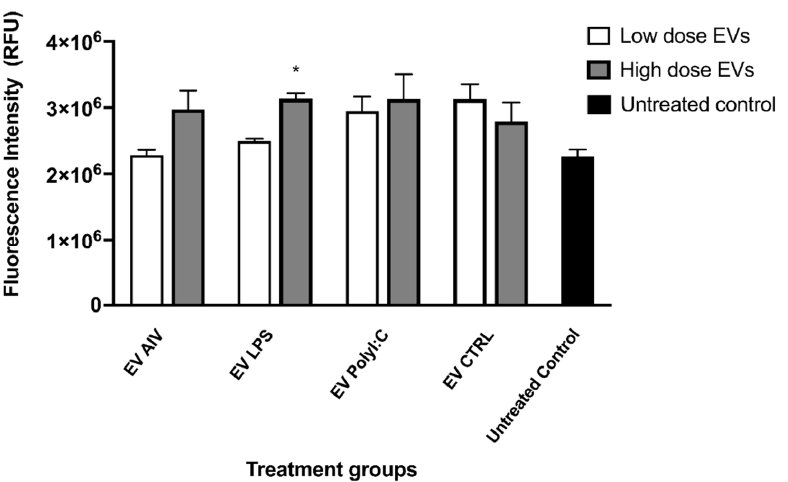
Figure 7. Phagocytosis by chicken macrophage stimulated with EVs. Two doses of EVs were used to treat macrophages, low (5 µg/mL) and high (25 µg/mL). Phagocytosis was assessed by a fluorescent bead-based assay using pHrodo Red Escherichia coli Bioparticles Conjugates. No significant differences in fluorescence intensity (relative fluorescence units, RFU) were observed as a result of EV treatment. Treatment groups with significant differences ( p -value < 0.05) compared to the untreated control group are represented by *. The error bars represent the standard error of mean (SEM). To assess the ability of EV treatment to influence the relative gene expression levels in chicken macrophages, macrophages were treated with a low dose (5 µg/mL) or a high dose (25 µg/mL) of EVs and collected at two different timepoints, 3 h and 18 h post-stim- ulation (Figure 8). The relative expression levels of IFN- α , IFN- β , IL-1 β , PKR, and MDA5 were evaluated. We evaluated the relative gene expression levels of macrophages treated with EVs from chicken tracheal cells stimulated with AIV and LPS, as well as our EV CTRL group. Given the large amount of treatment groups from the different dosages and timepoints, we chose to exclude the EV polyI:C for this part of the experiment. The stim- ulation of macrophages with EV AIV, both low and high doses, as well as with a high dose of EV CTRL induced significant up-regulation of IFN- α at 3 h post-stimulation (Fig- ure 8a). Furthermore, there is an overall decrease in relative gene expression for both IFN- α and IFN- β in all treatment groups at 18 h versus 3 h post-stimulation, with significant differences observed for the high dose of EV AIV for both IFN- α and IFN- β and the low dose of EV LPS for IFN- α only (Figure 8a,b). All treatment groups for both timepoints showed significant upregulation of IL-1 β (Figure 8c). In addition, the upregulation of IL- 1 β for EV AIV and EV LPS groups is dose dependent. For PKR, there was no significant difference in relative gene expression at 3 h post-stimulation; however, there was signifi- cant downregulation for all of the EV groups at 18 h post-stimulation (Figure 8d). Simi- larly, there was no significant difference in relative gene expression at 3 h post-stimulation for MDA5 (Figure 8e). At 18 h post-stimulation, there was significant downregulation for all of the EV groups.